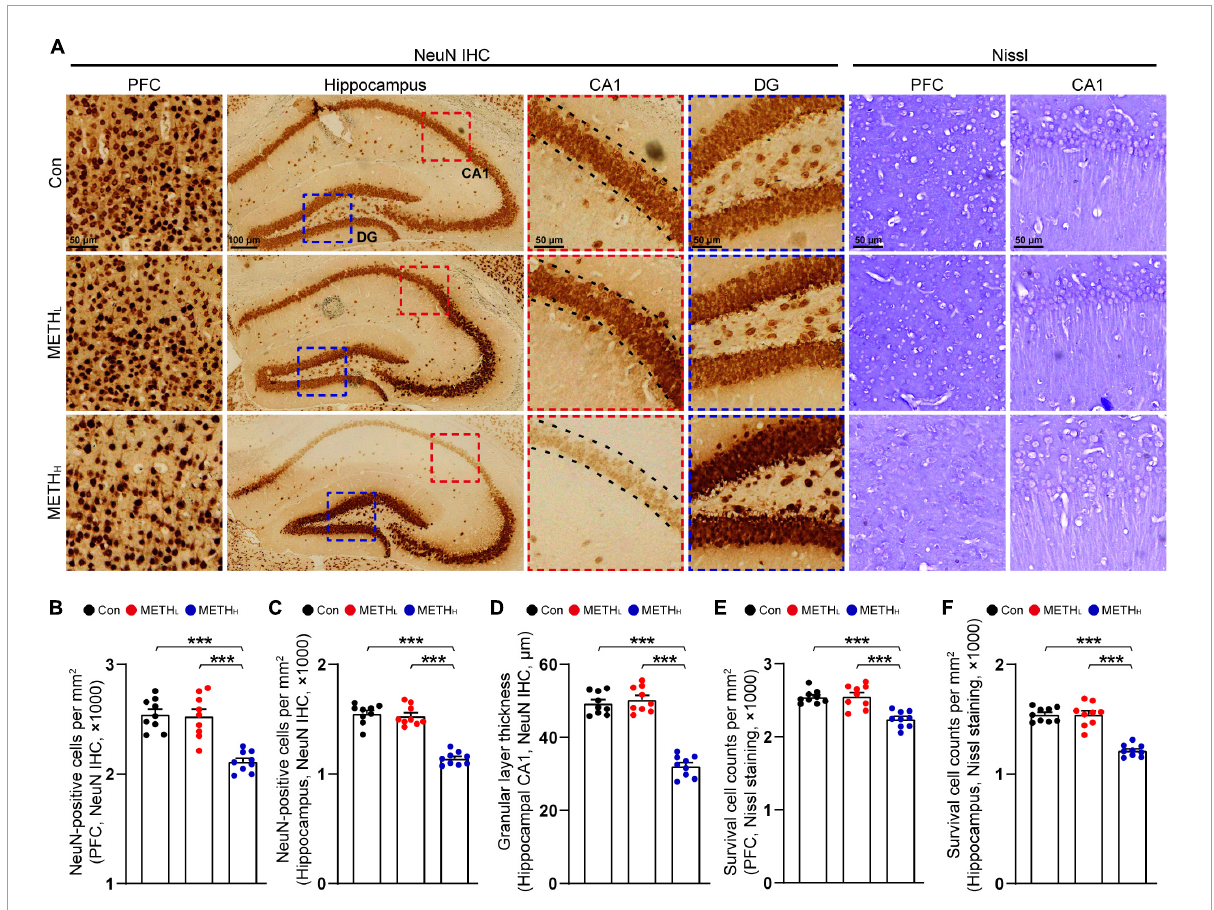
FIGURE5 Effect of METH on neuronal number. (A) Representative figures of NeuN IHC staining and Nissl staining in cortex and hippocampus. (B) Quantification of NeuN + cell density in cortex of control, METH L and METH H mice. One-way ANOVA, F (2, 26) = 23.786, p < 0.001. (C) Quantification of NeuN + cell density in hippocampal area of control, METH L and METH H mice. One-way ANOVA, F (2, 26) = 72.334, p < 0.001. (D) Quantification of granular layer thickness in hippocampal CA1 area from NeuN IHC staining. One-way ANOVA, F (2, 26) = 95.847, p < 0.001. (E) Quantification of survival cell counts in cortex from Nissl staining. One-way ANOVA, F (2, 26) = 18.671, p < 0.001. (F) Quantification of survival cell counts in hippocampus from Nissl staining. One-way ANOVA, F (2, 26) = 53.05, p < 0.001. n = 9 sections, 3 sections per mouse. *** p < 0.001 by one-way ANOVA and Bonferroni’s post hoc